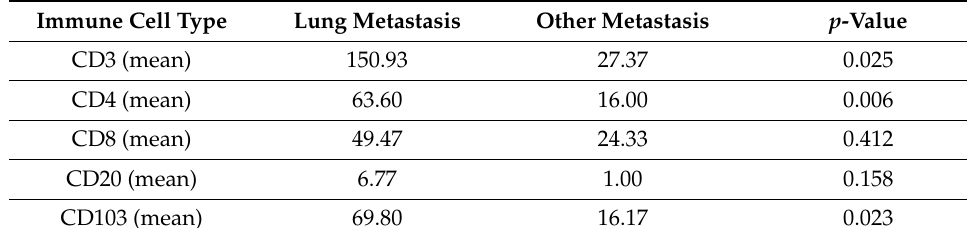
Table 6. Comparison of the immune cell infiltration in distant metastases (Mann–Whitney U test, Bonn cohort, n = 25 patients).